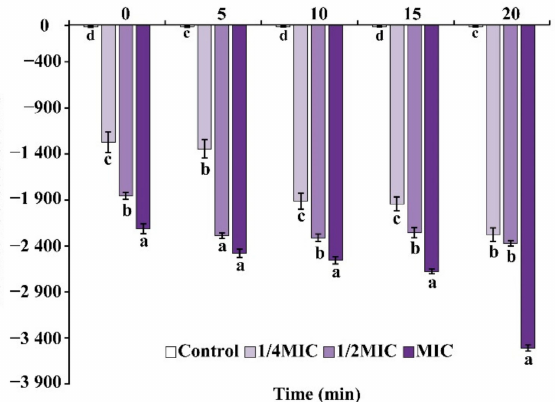
Figure 3. Effect of OEO on the membrane potential of E. faecalis ATCC 29212. Different small letters in each time indicate significant ( p < 0.05) statistical differences among treatments.